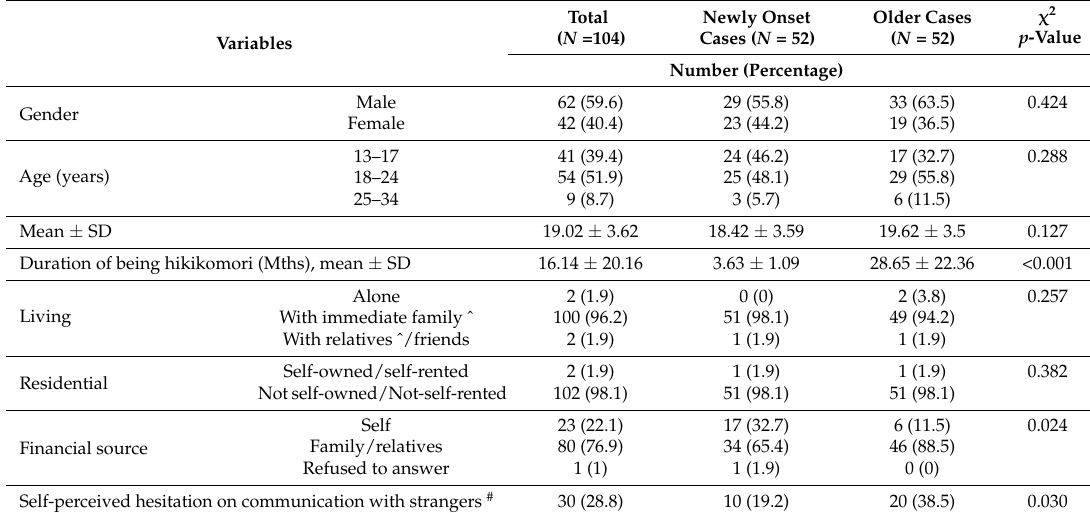
Table 1. Demographic characteristics of hikikomori youths living in Hong Kong.